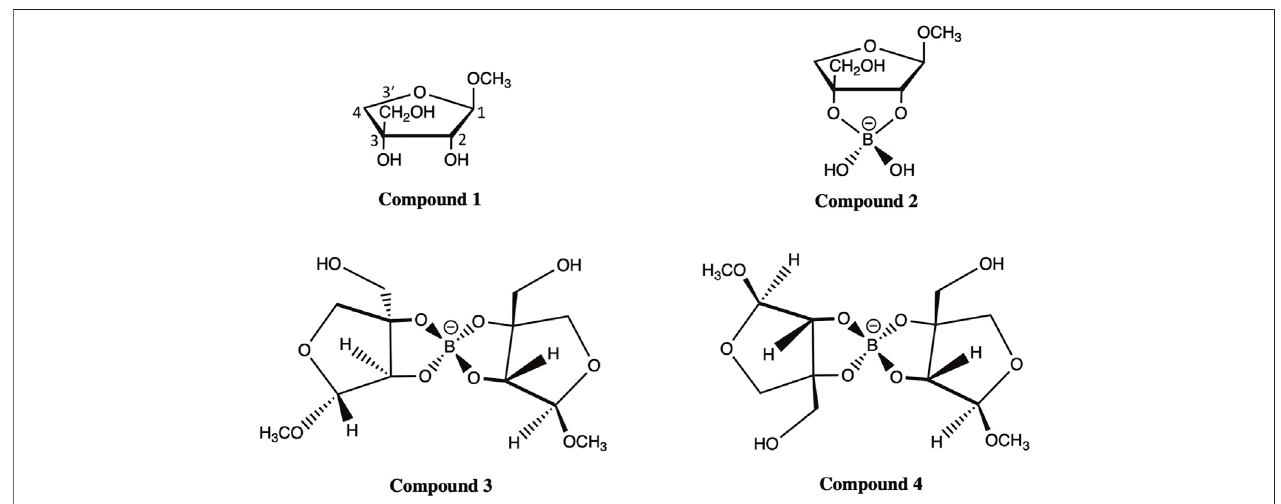
FIGURE 2 | Compounds 1 – 4 of methyl apioside and apio – borate esters (Ishii and Ono,